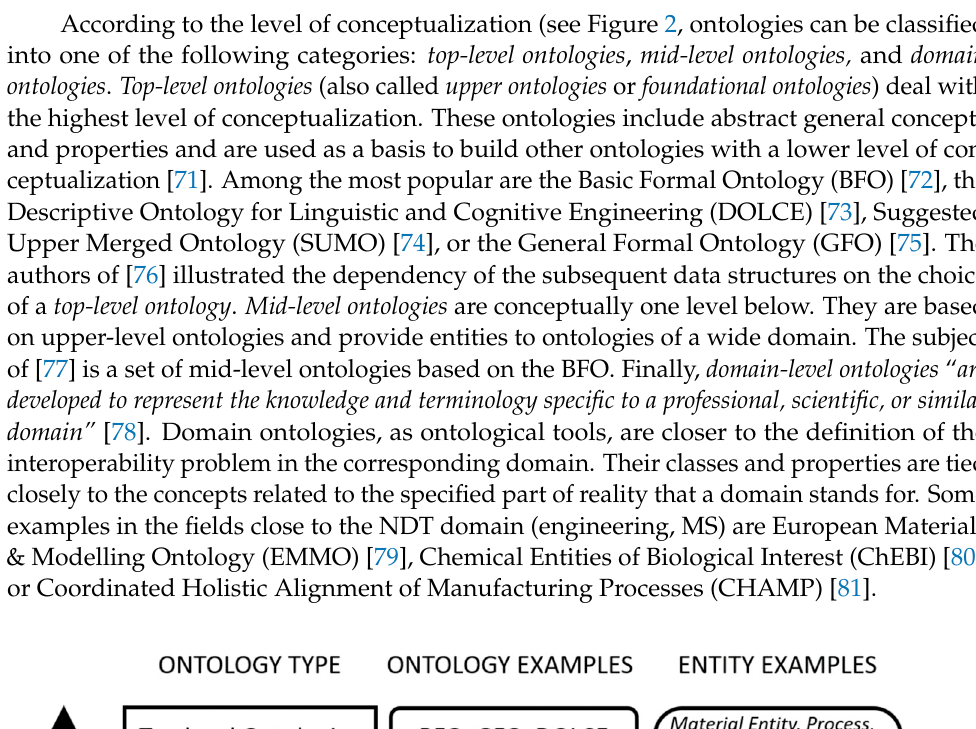
Figure 1. The structure of a triple (Subject ‐ property ‐ Object), when related to a knowledge model (such as an ontology, top) and a set of data in tabular form (bottom left), provides a set of triples (bottom center ‐ right).